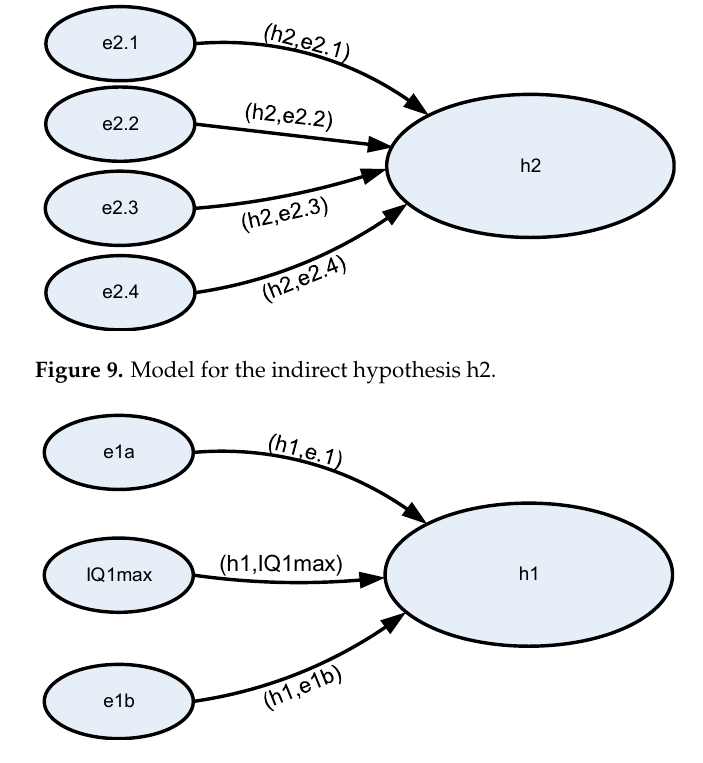
Figure 10. Model for the indirect hypothesis h1 (IQ1max—this is the maximum value that the hypothesis factor can reach [40]).